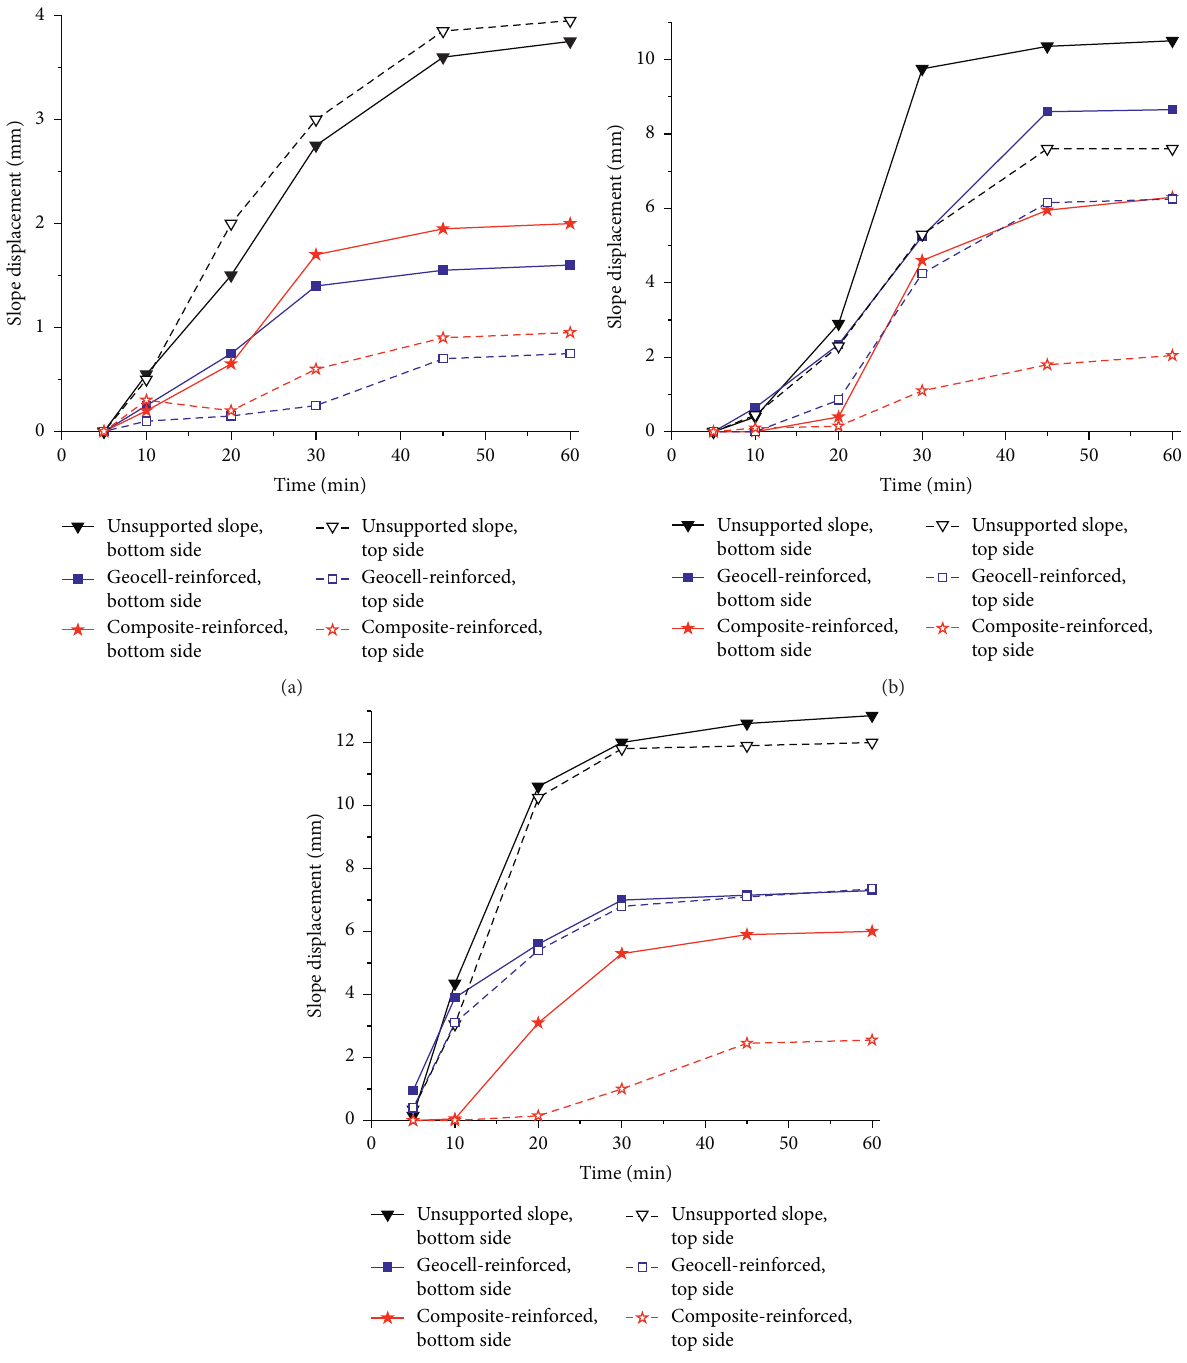
Figure 9: Slope displacement during rainfall: (a) rainfall intensity: 50mm/h; (b) rainfall intensity: 75mm/h; (c) rainfall